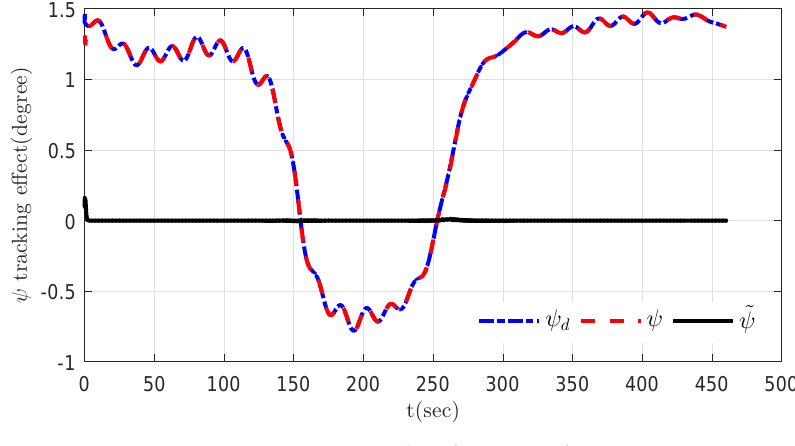
Figure 6. Control performance of ψ .